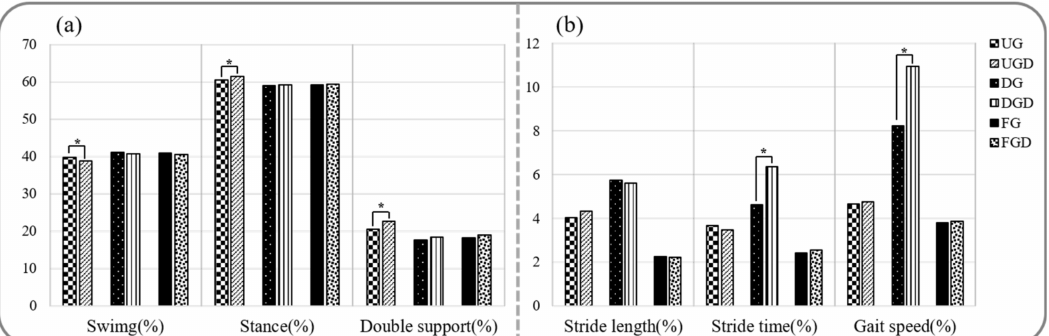
Figure 2. Comparison of spatiotemporal gait parameters while performing or not the cognitive task. UG: uphill gait, UGD: uphill gait with dual-task, DG: downhill gait, DGD: downhill gait with dual-task, FG: flat gait, FGD: flat gait with dual-task. * p < 0.05.